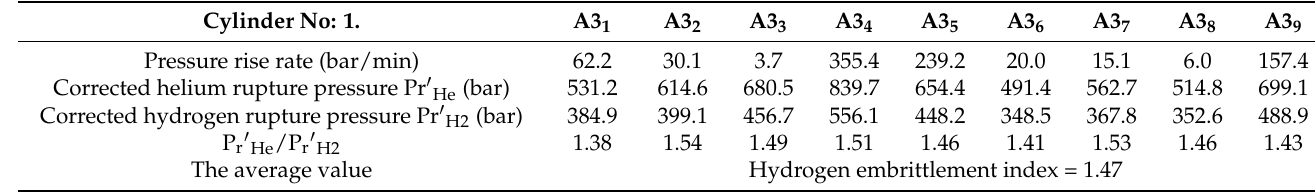
Table 4. The P r (cid:48) He /P r (cid:48) H2 ratio for a three-cylinder body.